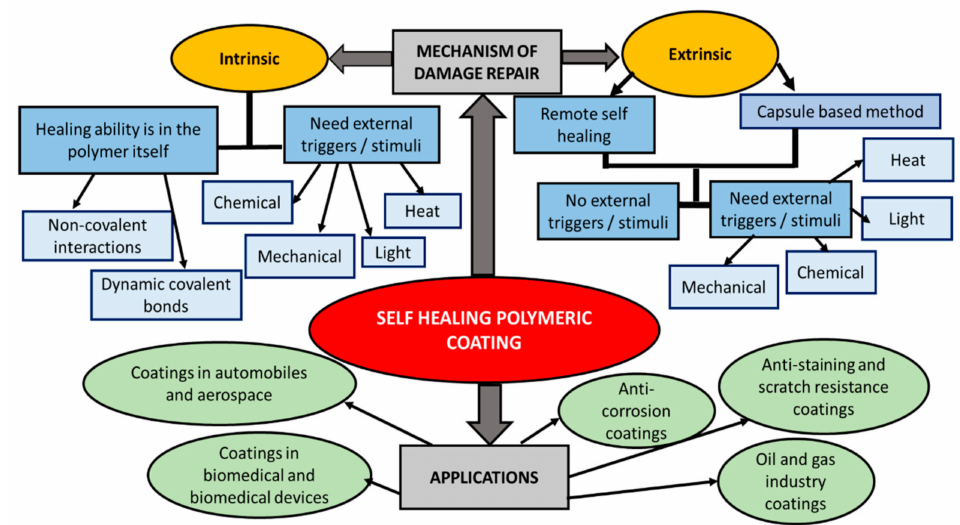
Figure 7. Self-healing polymeric coatings, mechanisms, and